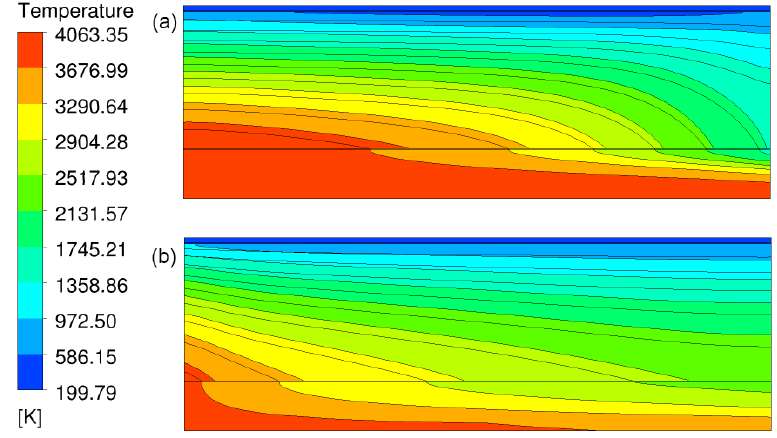
Figure12. TemperaturefieldinPBRsofincreasedresistanceofcoldfritorhotfrit. ( a )Coldfrit-dominated Figure 12. Temperature field in PBRs of increased resistance of cold frit or hot frit. ( a ) Cold frit- PBR; ( b ) hot frit-dominated dominated PBR; ( b ) hot frit-dominated PBR. Table 5. Main geometrical parameters of the PBR.